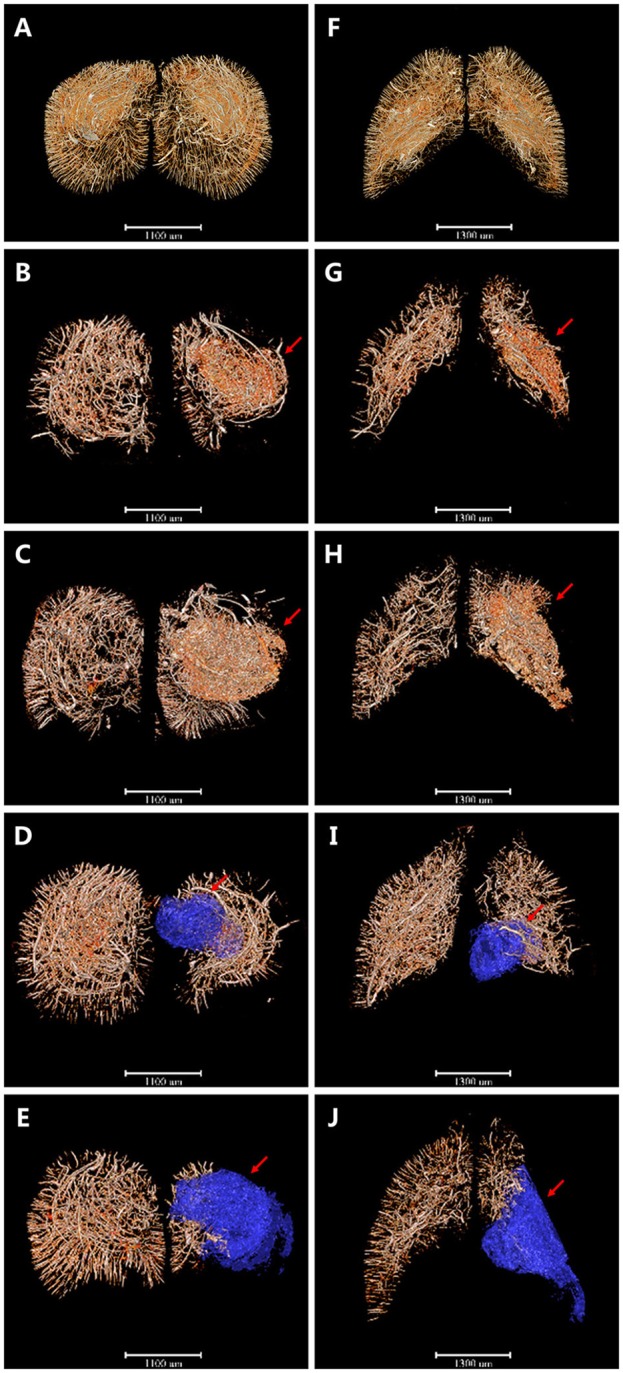
3D angioarchitecture maps supplying the pre-frontal lobe cortex and corpus striatum region (defined as the region of interest, ROI) after ischemia in coronary and horizontal view. Red region refers to region that microvessels accumulated and blue region presents ischemic cavity with no microvessels. (A–E) The coronary plane. (F–J) The horizontal plane. (A,F) sham operation group. (B,G) 4 h after MCAO. Microvessels with abundant branches began to appear around the ischemic area (red arrow). (C,H) 6 h after MCAO. Intensity of microvessels increased obviously but only seen surround the focus spatially (red arrow). (D,I) 3d after MCAO. Vasculature in ROI decreased significantly with liquefactive necrosis and ischemic cavity (blue region pointed by red arrow) formation. (E,J) 18 d after MCAO. Ischemic side of brain sagged and atrophied with vasculature attenuated dramatically and ischemic cavity (blue region pointed by red arrow) enlarged. Scale bars: 1,100 μm (A–E) and 1,300 μm (F–J).